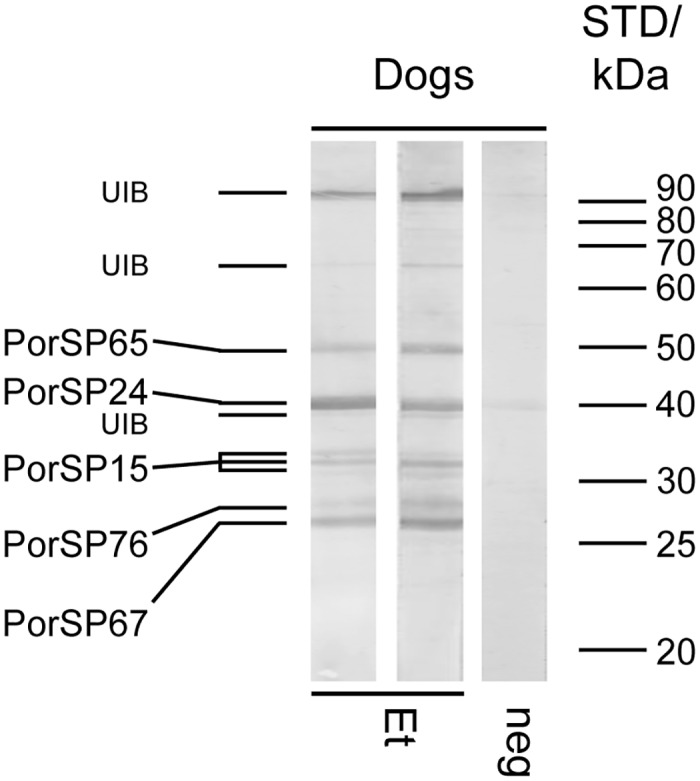
Identification of Phlebotomus orientalis salivary antigens in dogs.Ph. orientalis salivary proteins were separated under non-reducing conditions by SDS-PAGE on a 12% gel and incubated with two different pools of sera from naturally-exposed Ethiopian dogs (Et), and one pooled sera from non-exposed control dogs (neg). Each pool was a mixture of 5 individual samples. Five antigenic proteins (PorSP65, PorSP24, PorSP15, PorSP76, and PorSP67) were identified by successive proteome analysis and mass spectrometry. Molecular weights of standard (STD) are indicated. UIB means unidentified bands.